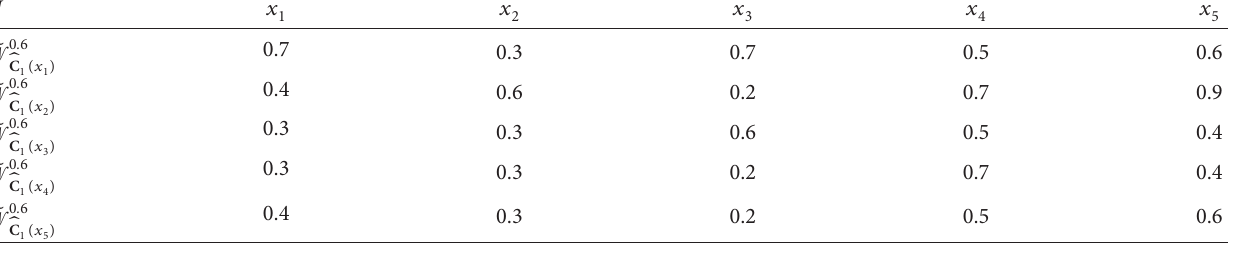
( j � 1 , 2 , ... , 5 ) . C 1 ( x j )